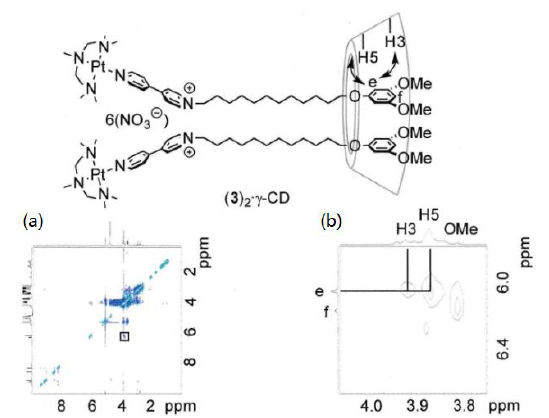
Figure 5. ROESY NMR spectra of [( 3 ) 2 · γ -CD] 6+ (D 2 O, 25 °C, 500 MHz). Total spectrum ( a ) and expanded spectrum ( b ).